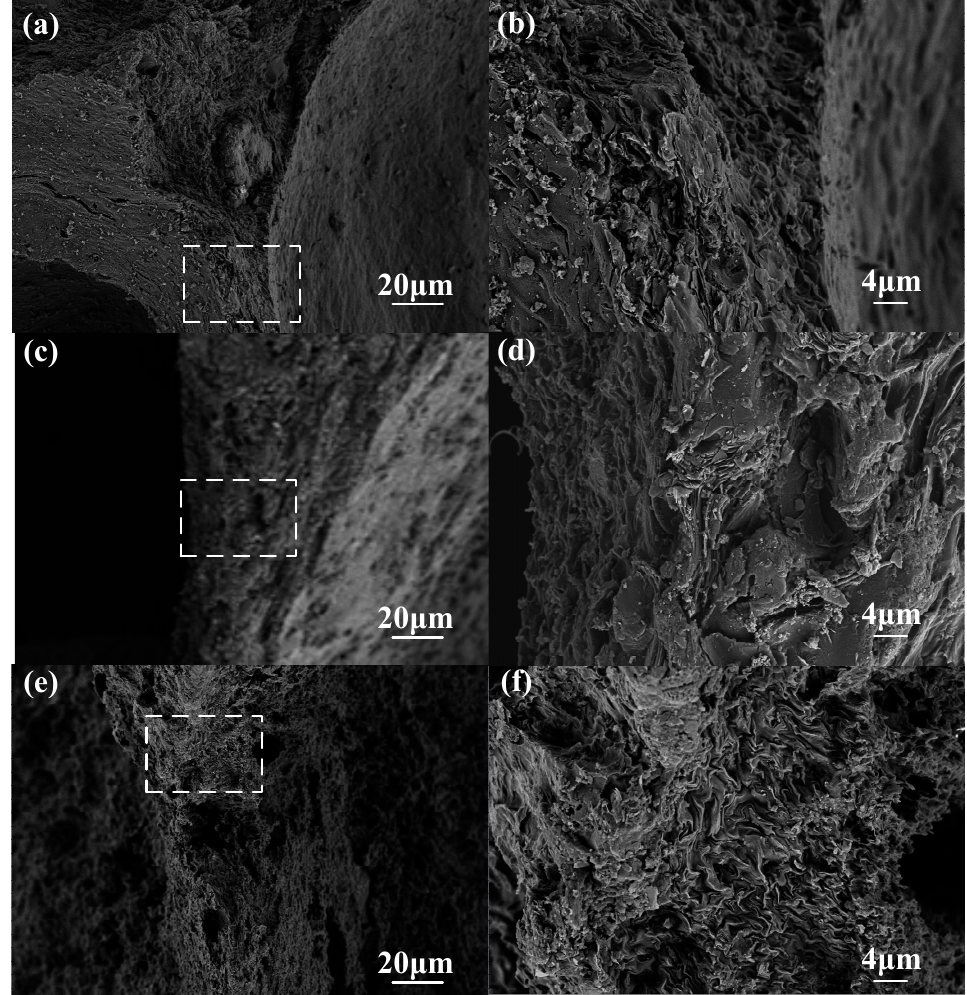
Figure 7. SEM images of pore-wall sections: ( a ) low magnification of A-2-1, 5.24% weight loss; ( b ) high magnification of A-2-1, 5.24% weight loss; ( c ) low magnification of A-3-3, 9.39% weight loss; ( d ) high magnification of A-3-3, 9.39% weight loss; ( e ) low magnification of A-4-3, 14.56% weight loss; ( f ) high magnification of A-4-3, 14.56% weight loss.